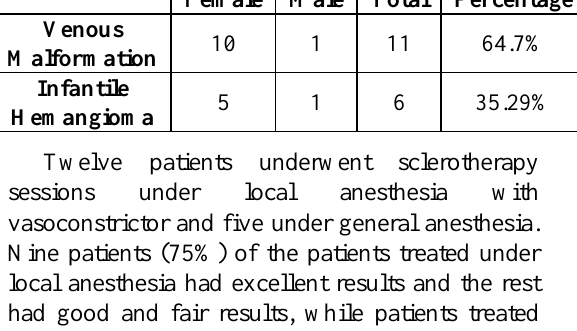
Fig 1: Syringes containing foam connected via 3-way stop cock, the first syringe contains 1 ml of liquid Polidocanol and the other contains 3 ml or room air.